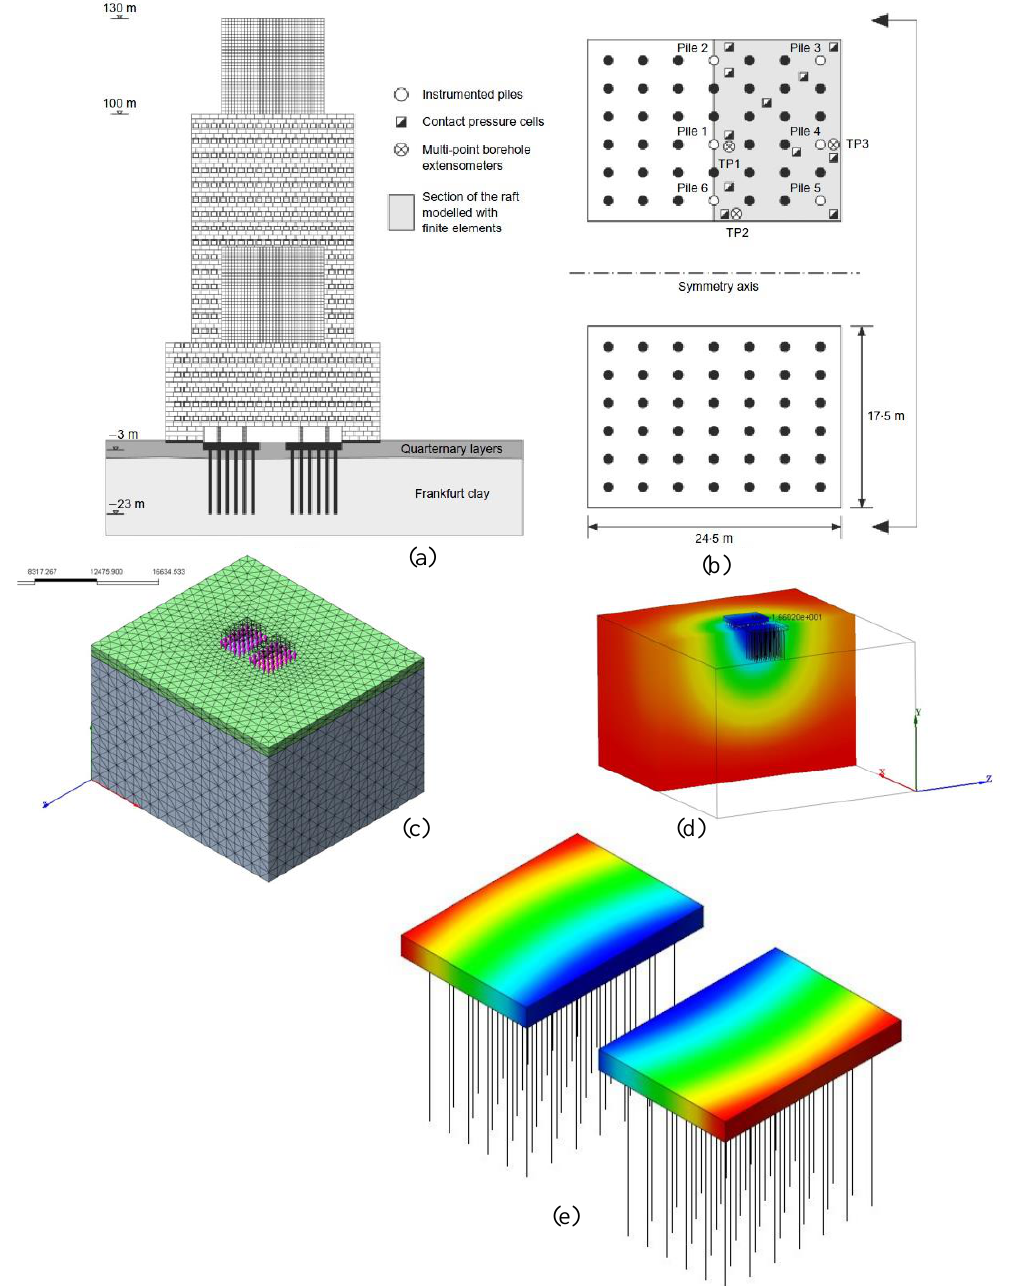
Fig. 17. (a), (b)Geometry details for Torhaus tower[26] (c), (d) and (e) validation process and result for Torhaus tower in MIDAS GTS